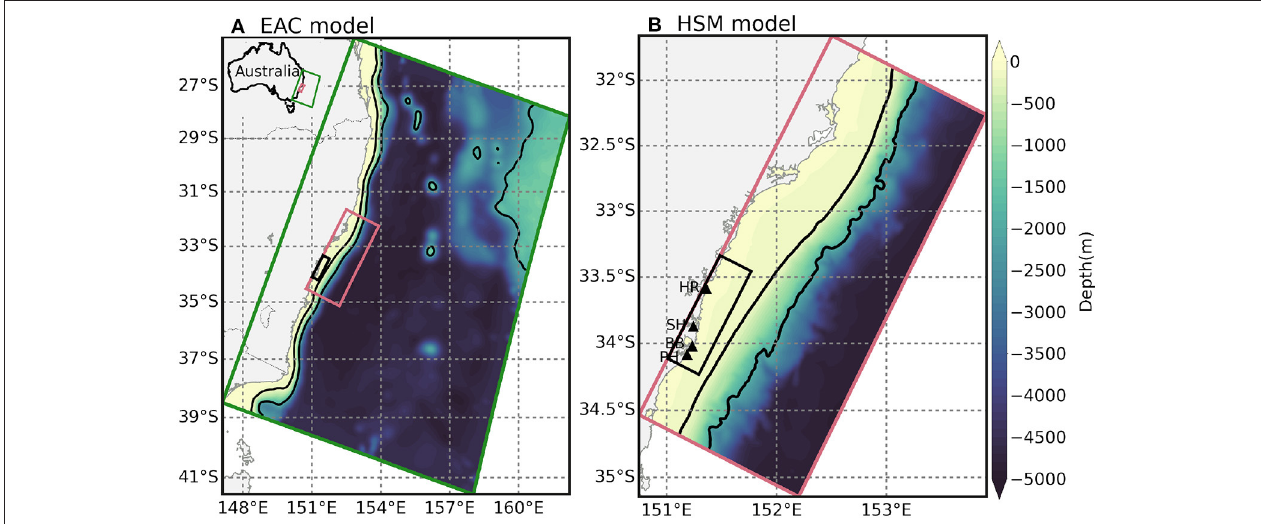
FIGURE 1 | Schematic diagram showing the model bathymetry (color shading) in the study site along the east coast of Australia in the model domains. (A) The EAC-ROMS parent model, and (B) the nested HSM model. The locations of the 4 rivers are indicated by the black triangles: Hawkesbury River (HR), Sydney Harbor (SH), Botany Bay (BB), and Port Hacking (PH). The black rectangle indicates the region covers the plumes from the four